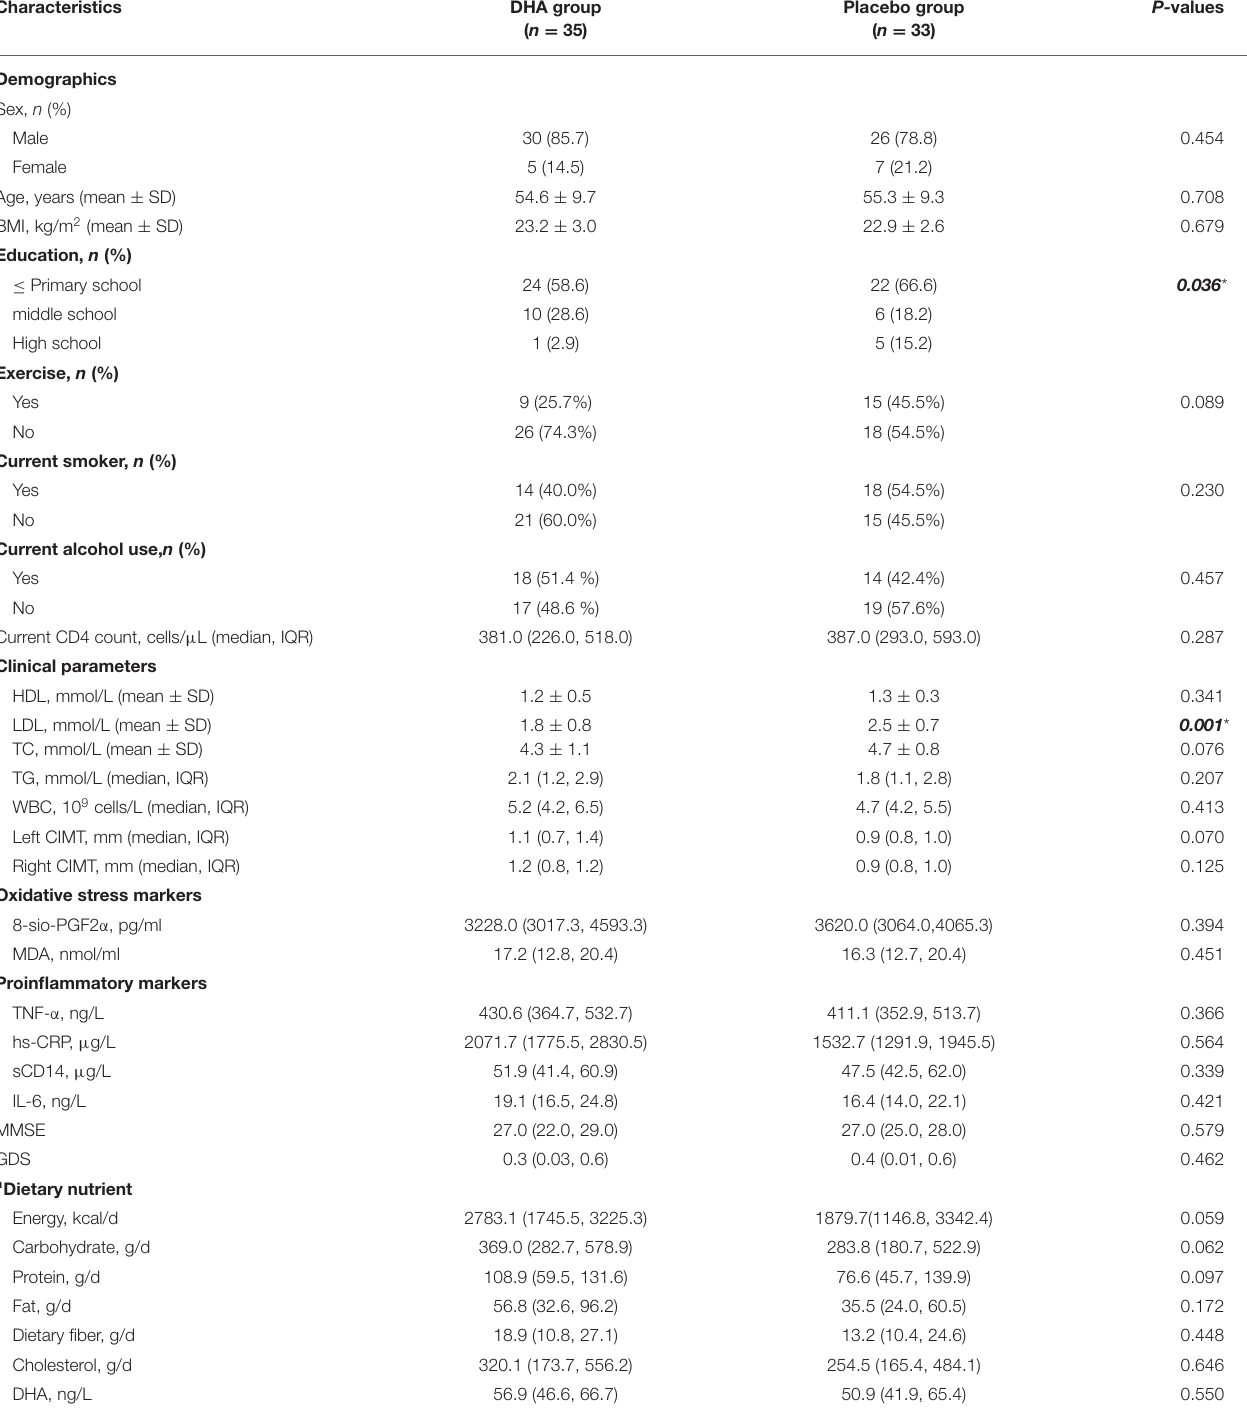
TABLE 1 | Baseline characteristics of the participants ( n = 68).